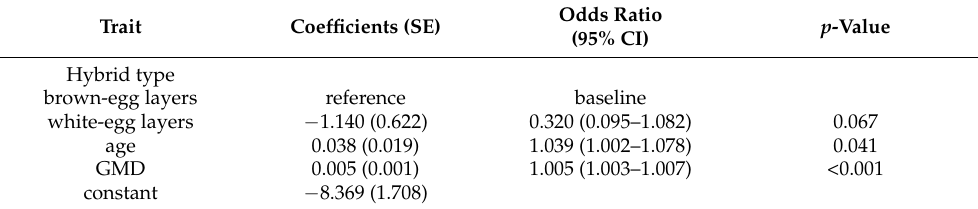
Table 4. Effects of hybrid type, age and geometric mean diameter of feed particles on the occur- rence of plumage damage in laying hen herds—results of a logistic regression model.